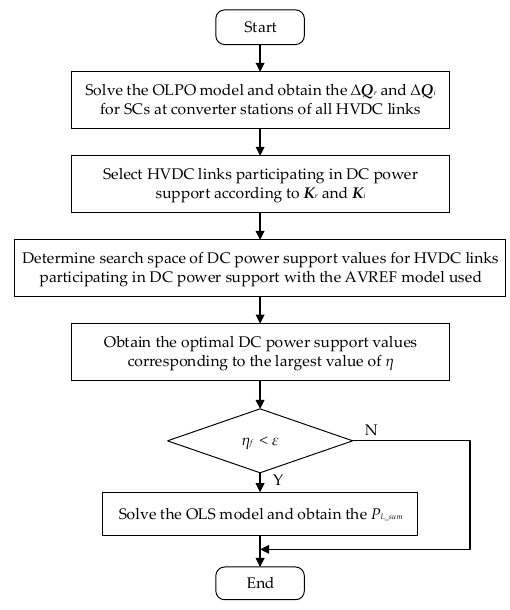
Figure 2. Flowchart of DC power support strategy.